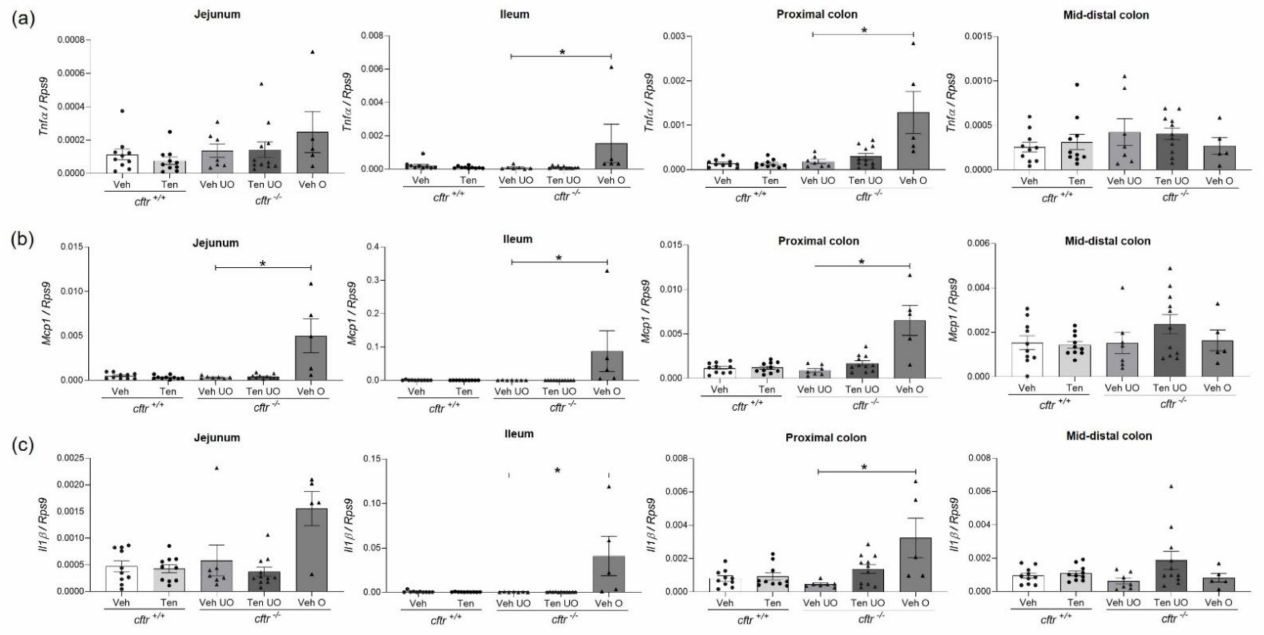
Figure 8. Inflammation in obstructed cftr − / − mice treated with vehicle. The mRNA expression of pro-inflammatory cytokines ( a ) Tnf α , ( b ) Mcp1 , and ( c ) Il1 β were not significantly different between genotypes or between the tenapanor vs. vehicle-treated mice without obstruction but showed a dramatic increase in the ileum and proximal colon of obstructed cftr − / − mice. Each dot/triangle represents one mouse. Veh—vehicle, Ten—tenapanor, UO—unobstructed, O—obstructed. Data are represented as means ± SEM. # is used to represent the statistical analysis performed between the two different genotypes and * is used to represent the statistical analysis performed between the vehicle and tenapanor groups or between unobstructed and obstructed vehicle groups. # and *, p <